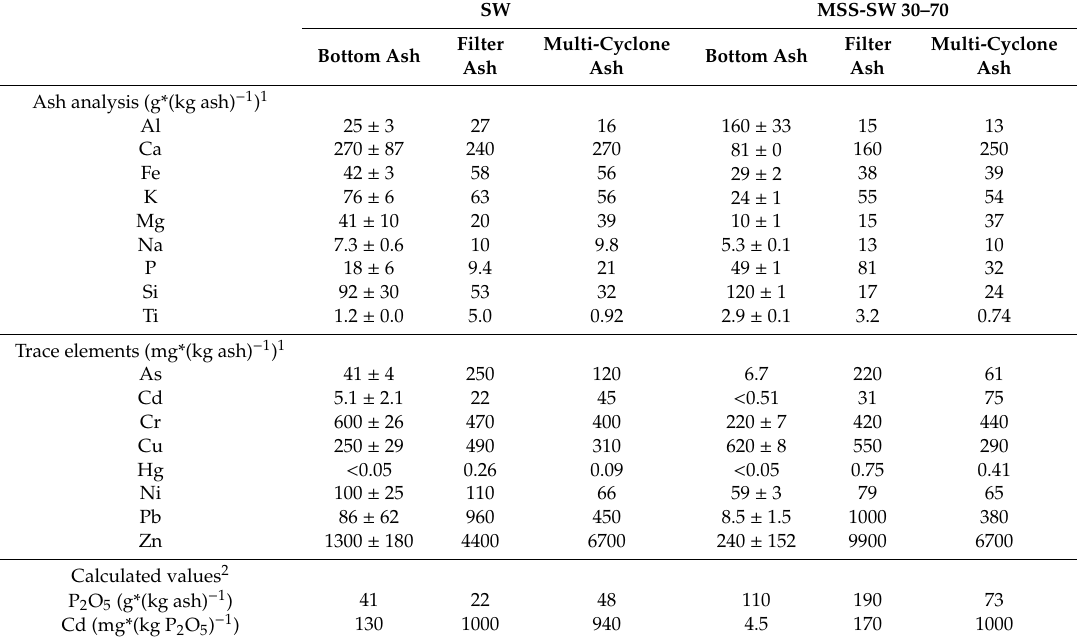
Figure 4. Bottom ash slag from the co-combustion of sewage sludge with soft wood, MSS-SW 30–70. Table 6. Results of the analysis of ashes, (bottom ash, filter ash and multi-cyclone ash). Comparison between the reference case SW and the fuel-mixture MSS-SW 30–70. Both bottom ashes are given as mean values with standard deviation (n =